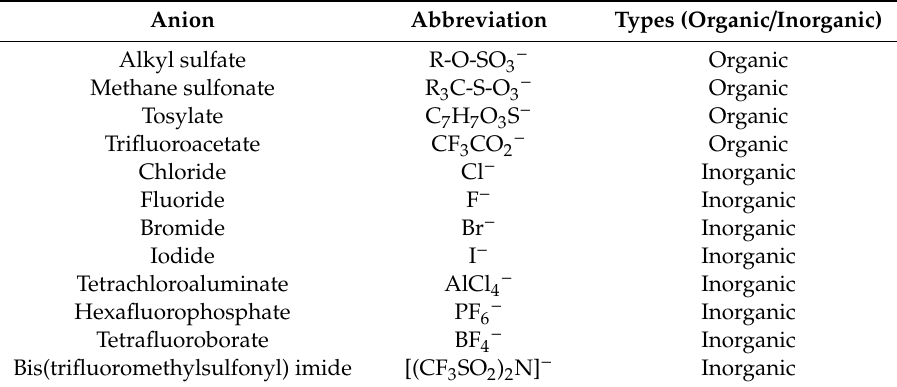
Table 2. Di ff erent types of anions existing in ionic liquids [89,90].